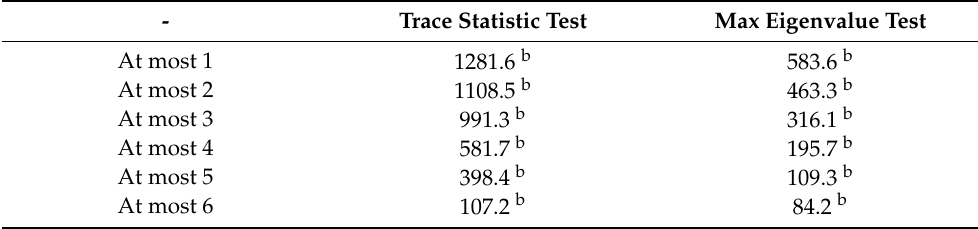
Table 6. Johansen Fisher panel co-integration test.